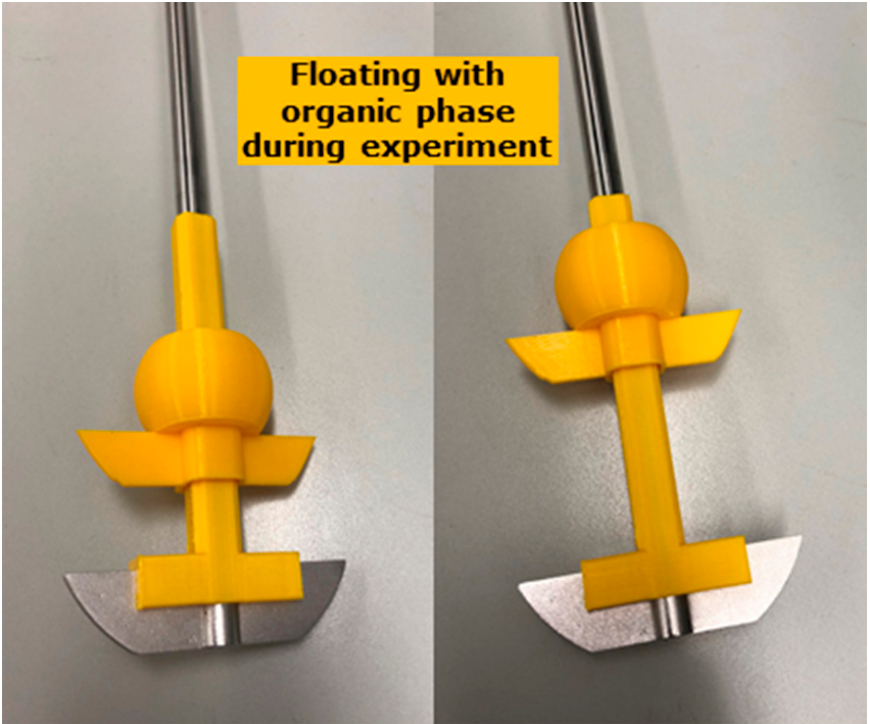
Figure 2. Representation of the 3D printed dynamic biphasic dissolution paddle device.